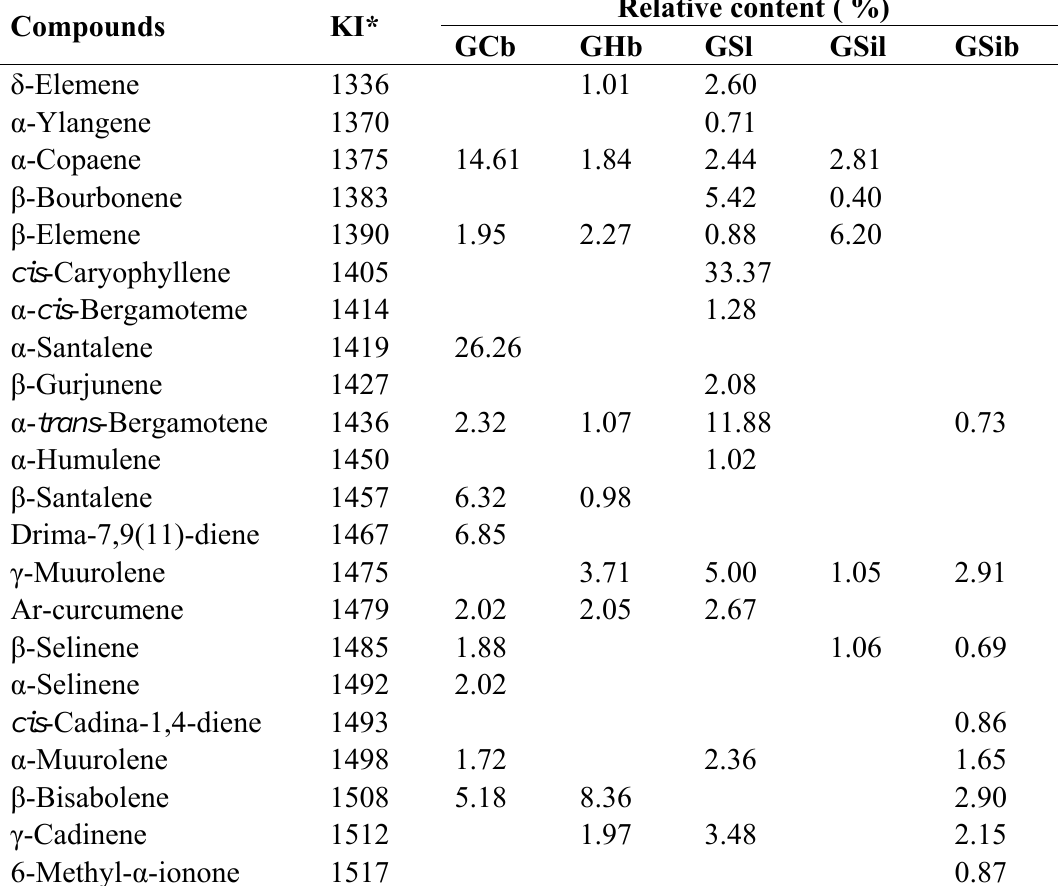
Table 2. Chemical compositions of essential oils from G. convergens , G. humaitensis , G. scabra and G.